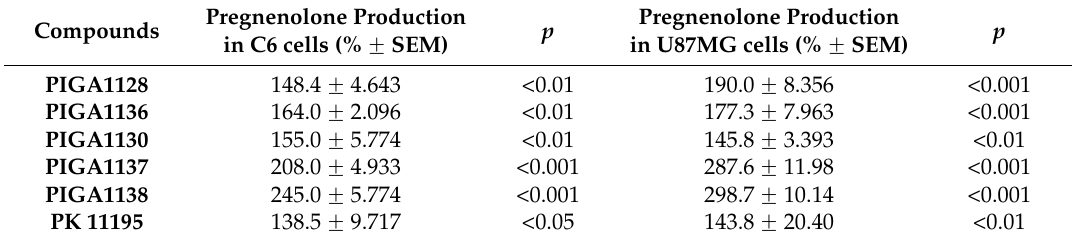
performed using one-way ANOVA and Bonferroni’s